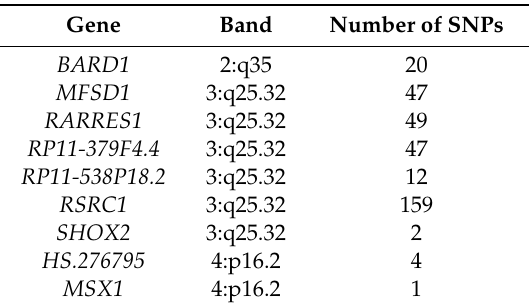
Table 6. eQTL mapping performed in shared and colocalizing susceptibility loci. Gene Band